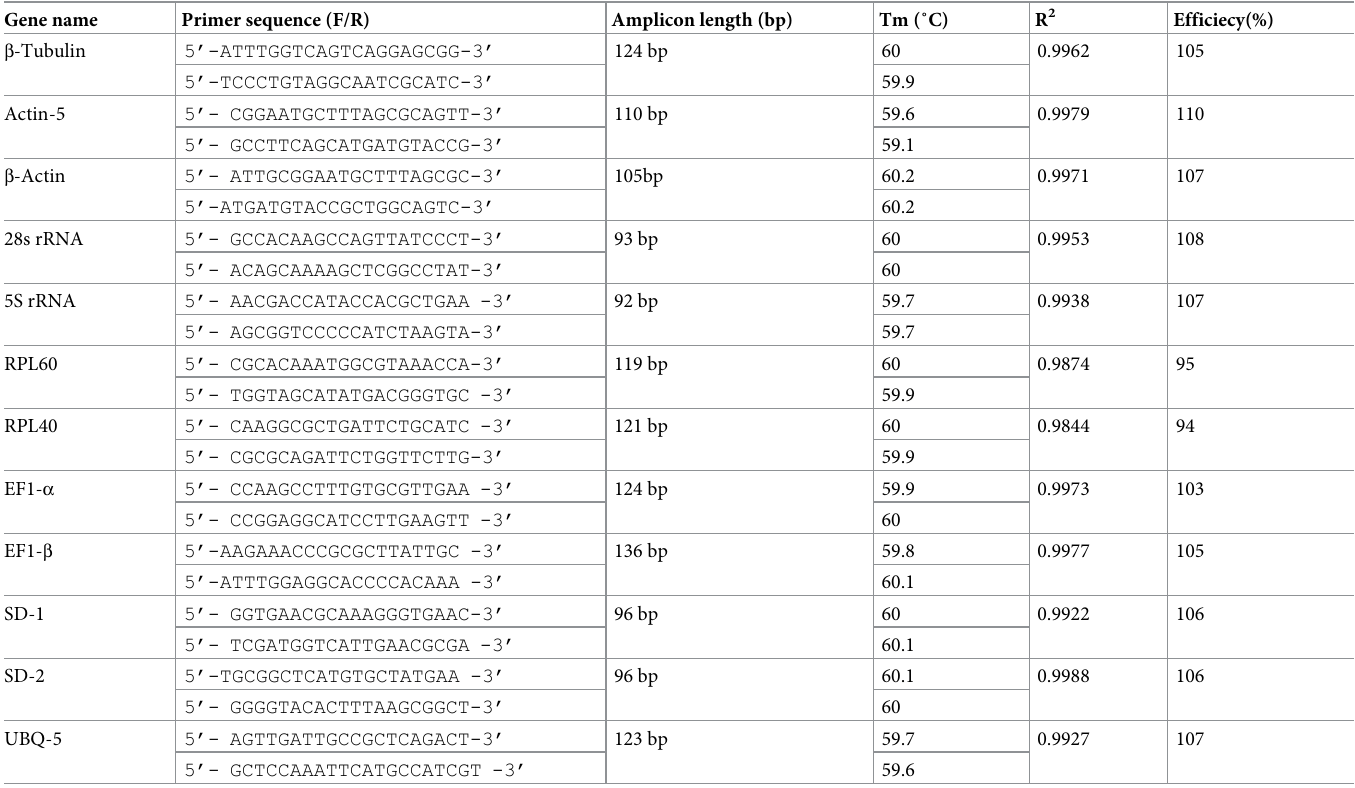
Table 2. Amplification characteristics of the twelve candidate reference genes in